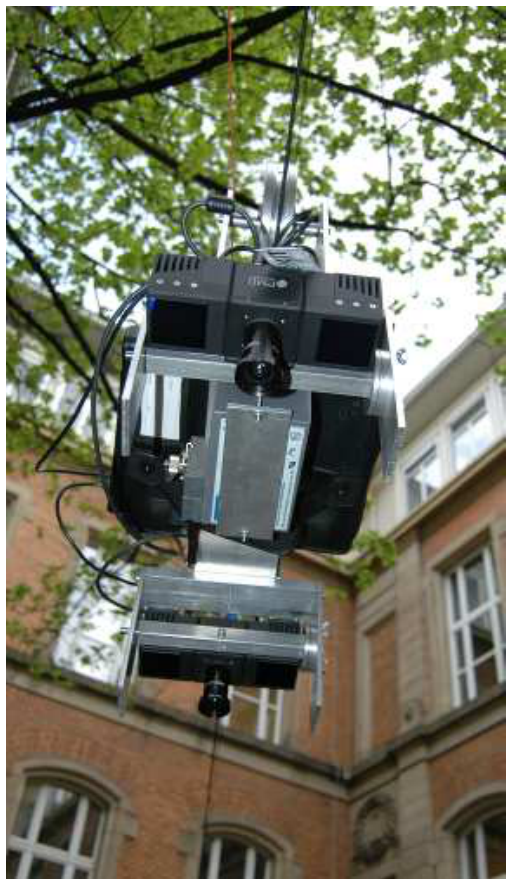
Figure 5. Experimental device while recording a scene.